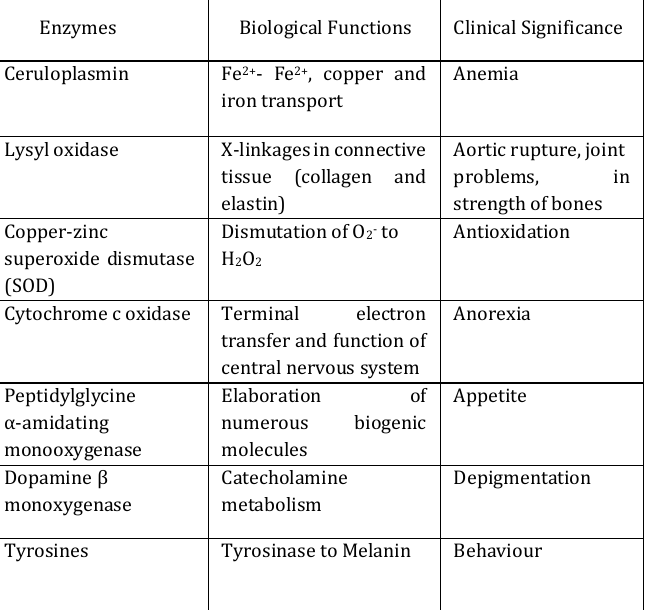
Table 1: summarizes the major copper dependent enzymes, their functions and clinical significance in the mammalian body. Enzymes Biological Functions Clinical